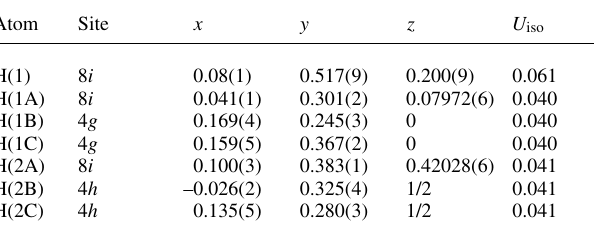
Table 2. Atomic coordinates and displacement parameters (in Å 2 )